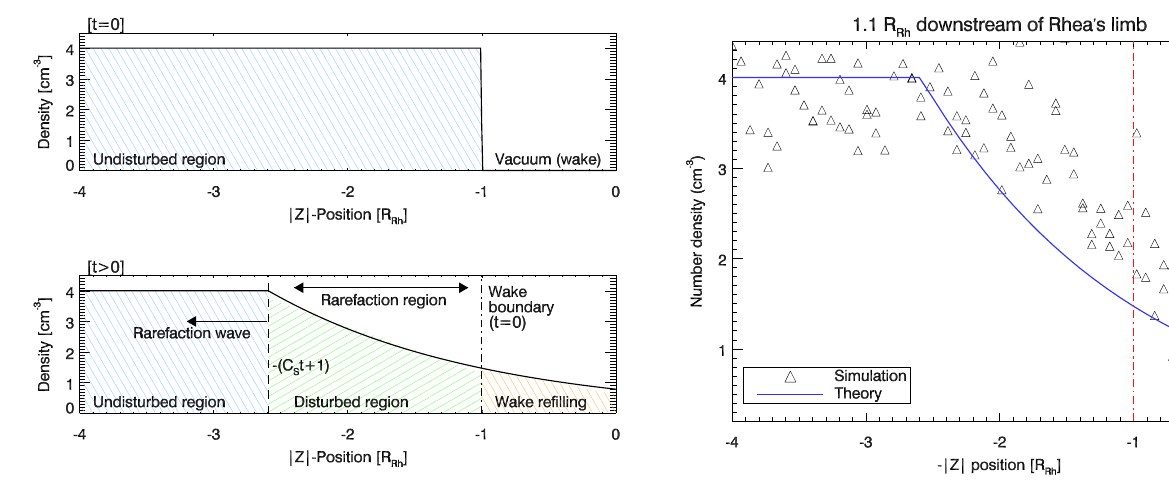
Fig. 3. Comparison of Eq. (7) solutions with the simulated data, for a distance of 1.1 R Rh downstream of Rhea’s limb. The scattering of the simulation data points is due to numerical noise, deriving from the small number of particles per simulation cell (about 15 particles per cell on